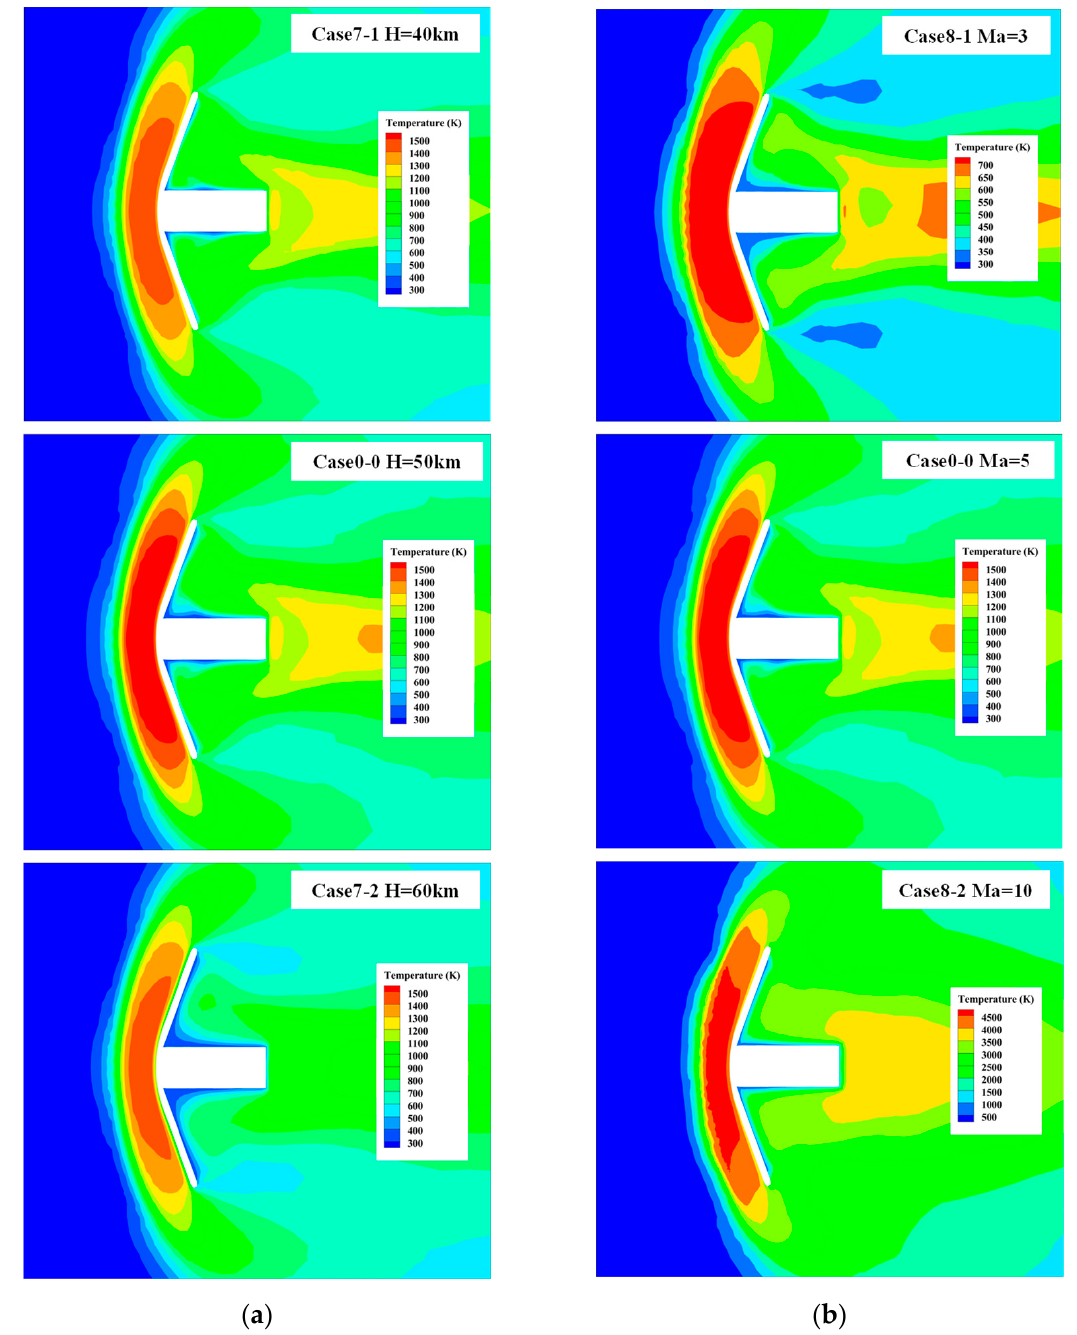
Figure 16. Temperature contours of case 0-0, case 7-1 to case 8-2: ( a ) H is changed; ( b ) Ma is changed. Heat flux distribution of changing H and Ma are shown in Figure 17 After the flight altitude of H changes, due to the obvious change in air density, the surface heat flux of the vehicle also changes significantly. The overall heat flux distribution decreases with an increase in H . When H = 40 km and Ma = 5, Q R reaches 70 kW/m 2 at the shoulder point. With an increase in Ma , aerodynamic heating is enhanced significantly. Q R reaches 380 kW/m 2 , which is far beyond the thermal protection limits of ordinary materials when Ma = 10. Therefore, it is necessary to reduce speed at a lower altitude to reduce aerodynamic heating as much as